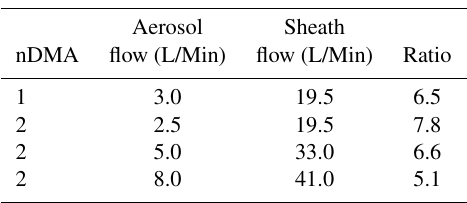
Table 1. Flow rates for the aerosol and sheath flow for the nDMAs used with the calculated sheath flow